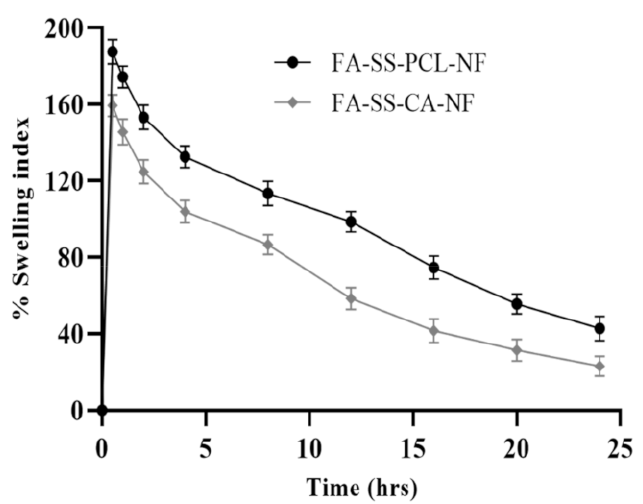
Figure 3. Swelling index (%) of FA-SS-PCL-NF- and FA-SS-CA-NF-optimized nanofibrous formula- tions in PBS at pH 7.4 (mean ±